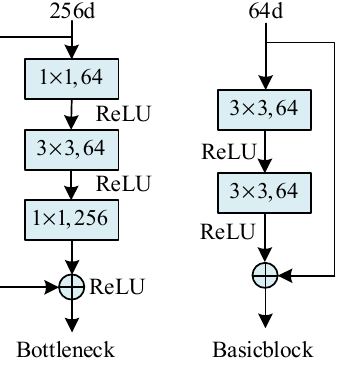
Figure 11. Bottleneck structure and Basicblock structure.